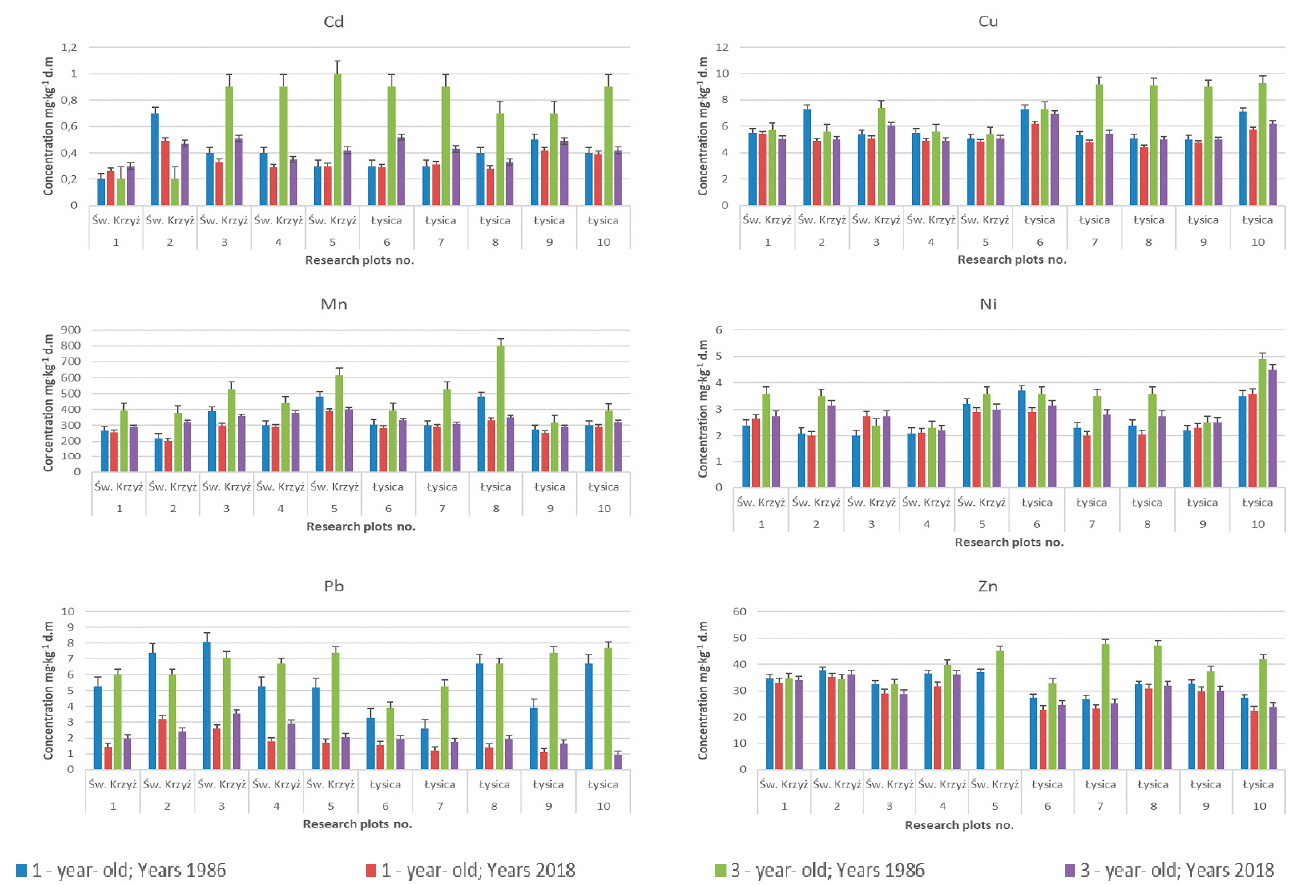
er than that in needles from 1986. The concentrations of cadmium, copper, manga- Figure 3. The contents of selected micronutrients in 1-year-old and 3-year-old silver fir needles in Figure 3. The contents of selected micronutrients in 1-year-old and 3-year-old silver fir needles in nese, and zinc in the one-year-old fir needles did not undergo any changes. milligrams per kilogram of dry matter (mg · kg − 1 d.m) (mean values ± SD). milligrams per kilogram of dry matter (mg·kg − 1 d.m) (mean values ± SD). From 1986 to 2018, the concentrations of cadmium, copper, manganese, and zinc in the three-year-old fir needles decreased by about 150% and the concentration of lead in the fir needles collected in 2018 was three times low